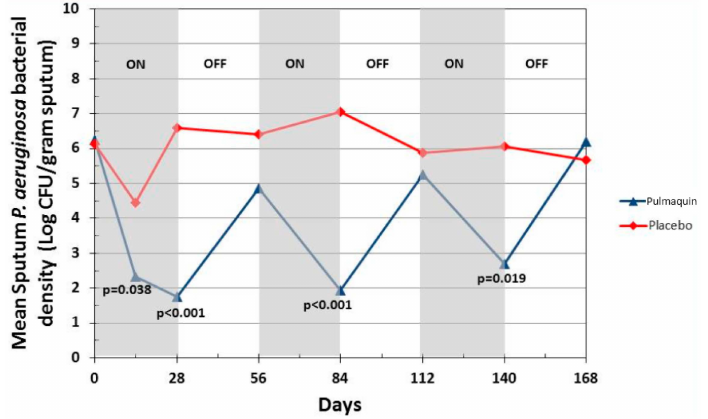
Figure 15. Change in mean sputum PA bacterial density across the 3 treatment cycles (28 days on followed by 28 days off) for Pulmaquin and Placebo groups in the modified intention to treat (mITT) population. Reprinted with permission from [21]. Copyright 2013